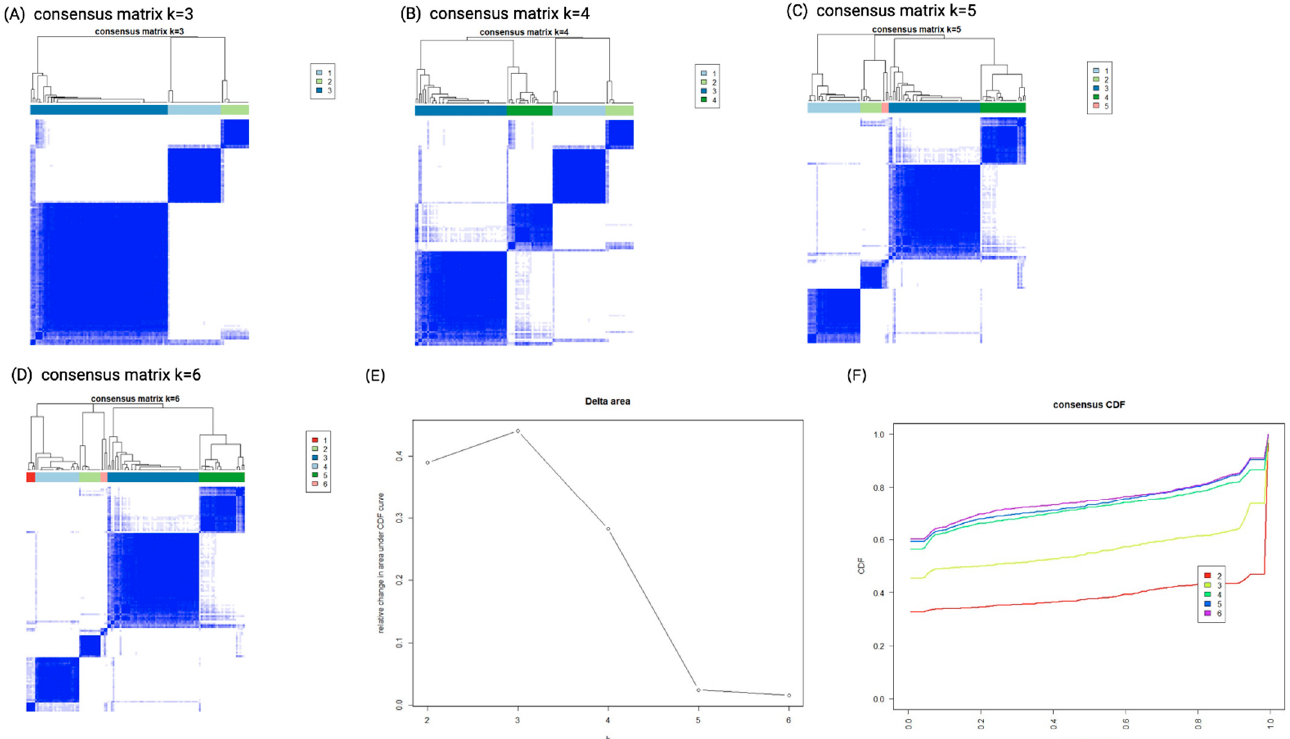
Figure 1. Consensus clustering analysis results displaying the robustness of sample classification using multiple iterations of k-means clustering. ( A – D ) The consensus matrix heat maps of K = 3, 4, 5 to K = 6 using 45 baseline parameters. The dark blue color shows the consensus of which groups fit perfectly together, and the white color shows that two individuals are always grouped separately. ( E ) Curve of CDF. ( F ) CDF delta area curve of consensus clustering. The x axis represents the category k, and the y axis denotes the relative change in area under the CDF curve of category k compared with category k − 1. Abbreviations: CDF, cumulative distribution